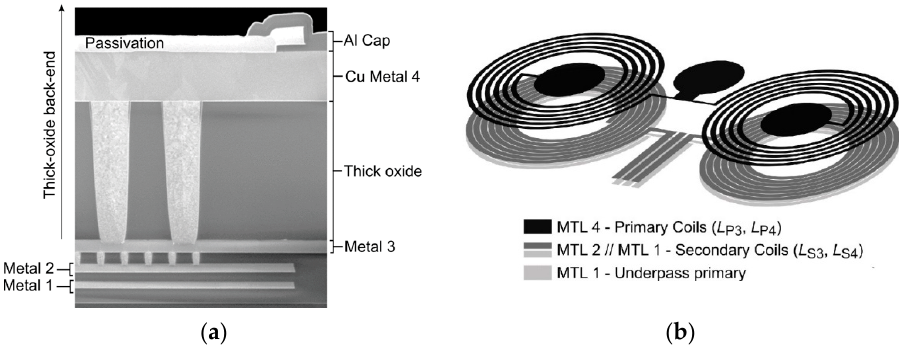
Figure 9. Isolation thick oxide transformer. ( a ) SEM cross-section. ( b ) Layout view of the data/control transformer with S -shape. Reproduced from [22]. Copyright 2018, IEEE.